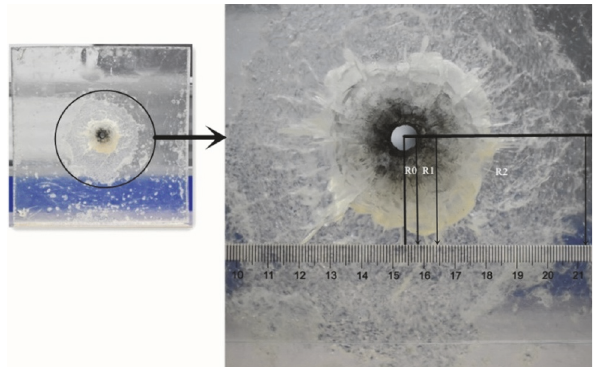
Figure 12: Transparent model specimen after